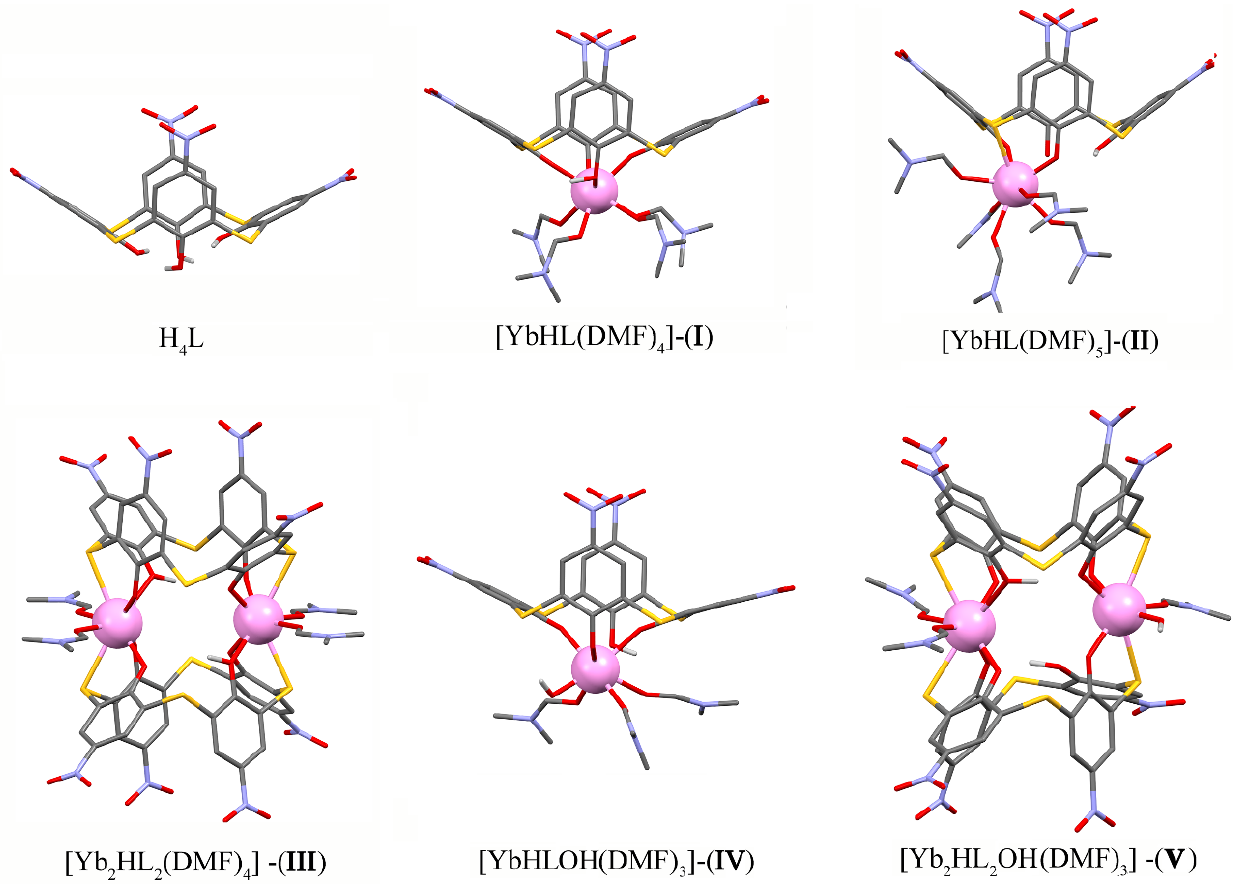
Figure 8. DFT-optimized structures of ligand H 4 L( 3 ) and its Yb 3+ complexes. Only hydrogen atoms of phenolic groups are shown for clarity.